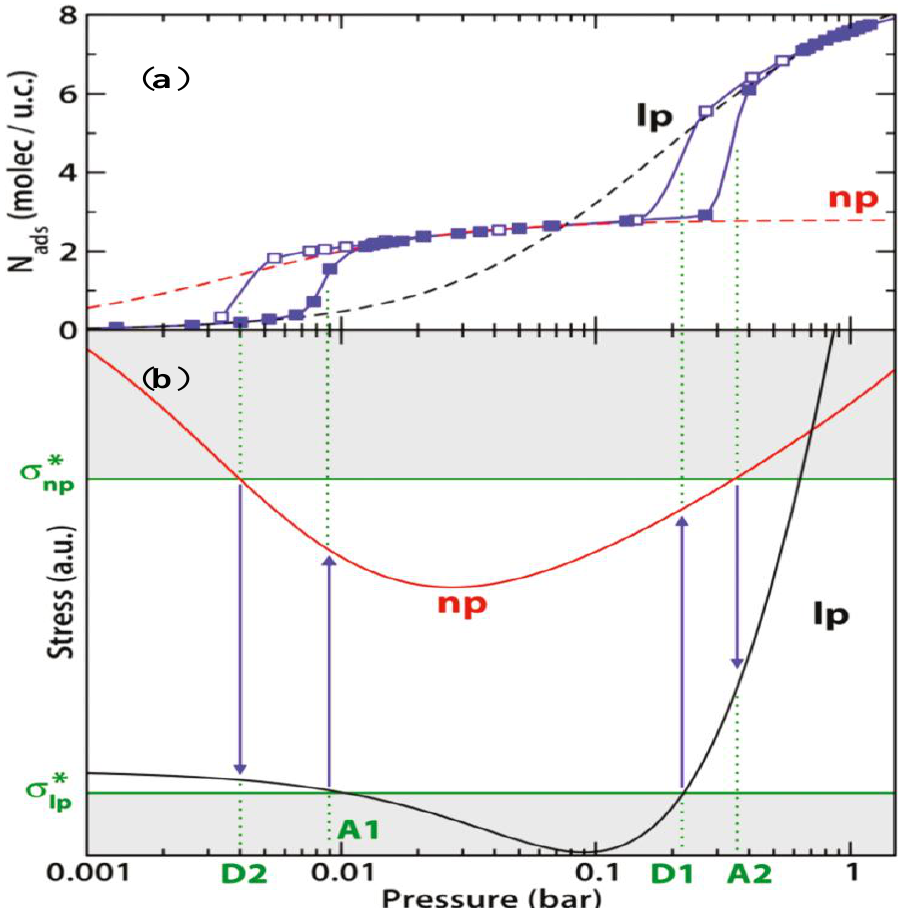
Figure 21. ( a ) Experimental adsorption (filled) and desorption (empty) isotherms of Xe in MIL-53(Al) at 220 K (in blue), and the fitting of Langmuir isotherms using the lp (black dash) and np (red dash) forms, respectively; ( b ) simulated structural transition stresses of the lp (black) and np (red) forms. σ* and σ* denote the critical stresses of the structural np lp transitions upon adsorption (A1 and A2) and desorption (D1 and D2), respectively. Reprinted with permission from [128]. Copyright 2010 American Chemical